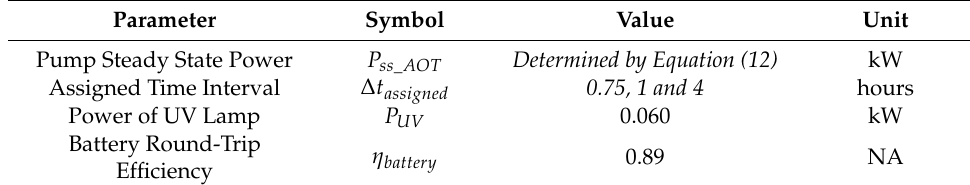
Table 7. Parameters for Equation (13) specifying parameter, symbol used, value and units used. Parameter Symbol Value P ss _ AOT